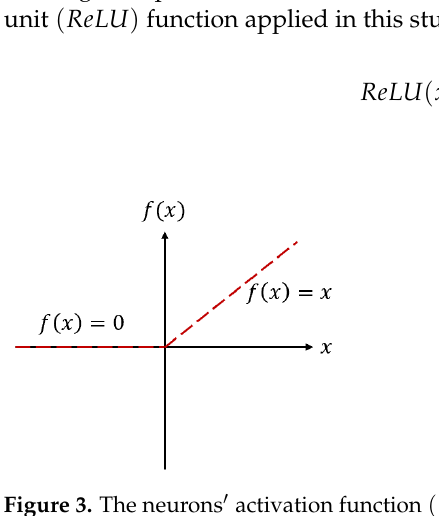
Figure 3. The neurons ′ activation function ( 𝑓).